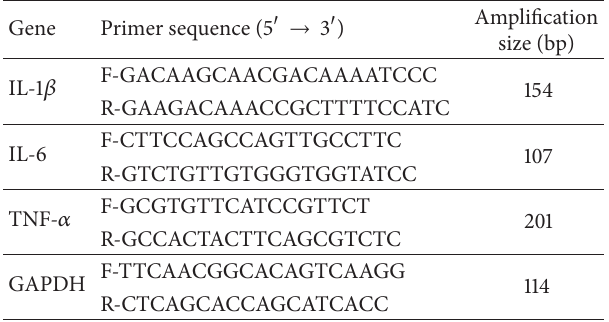
Table 2: Total time spent exploring the two objects during testing